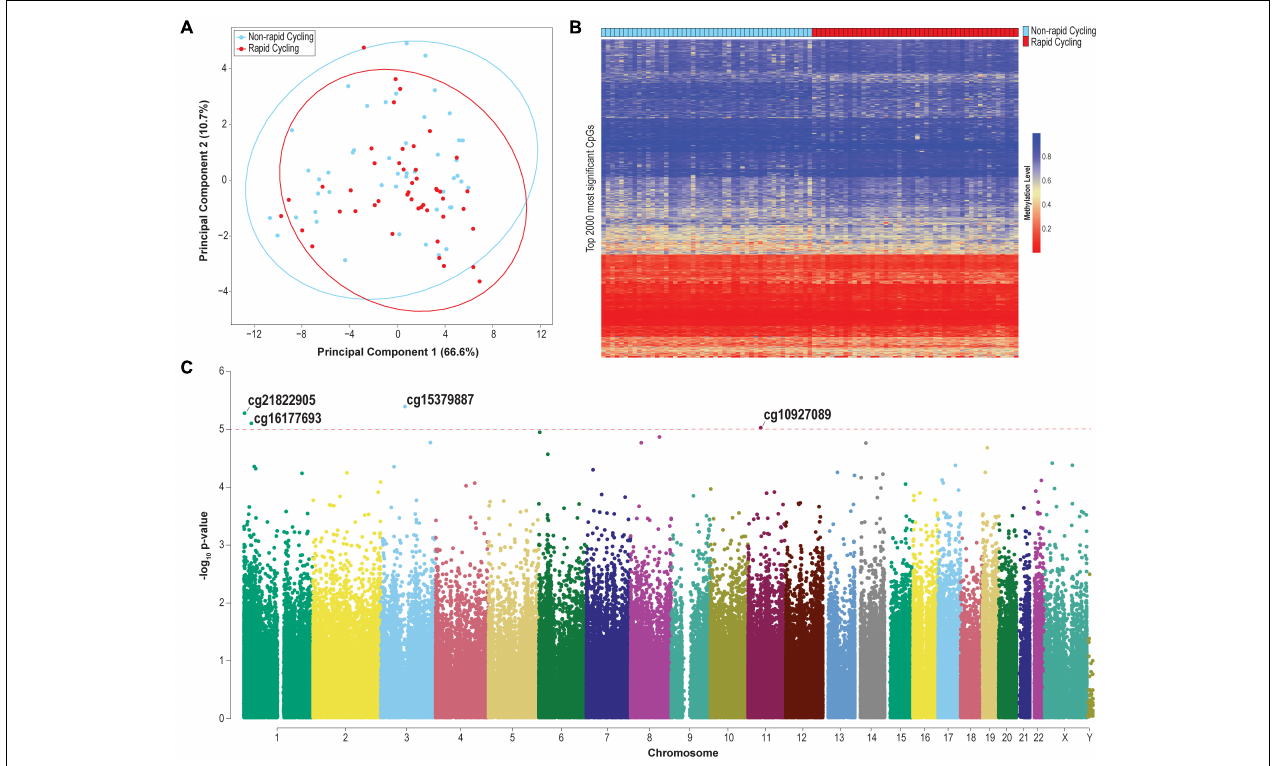
FIGURE 1 | (A) PCA plot based on the top 2,000 most variable probes (CpG sites located on chromosomes X and Y were excluded). (B) Heatmap of the methylation levels of the top 2,000 most significant differentially methylated probes. (C) Manhattan plot of genome-wide plasma cfDNA methylomic comparison between rapid cyclers and non-rapid cyclers among bipolar disorder patients. The CpG probes where the top differentially methylated sites ( p < 1E-05) are located are indicated. Red line: p =